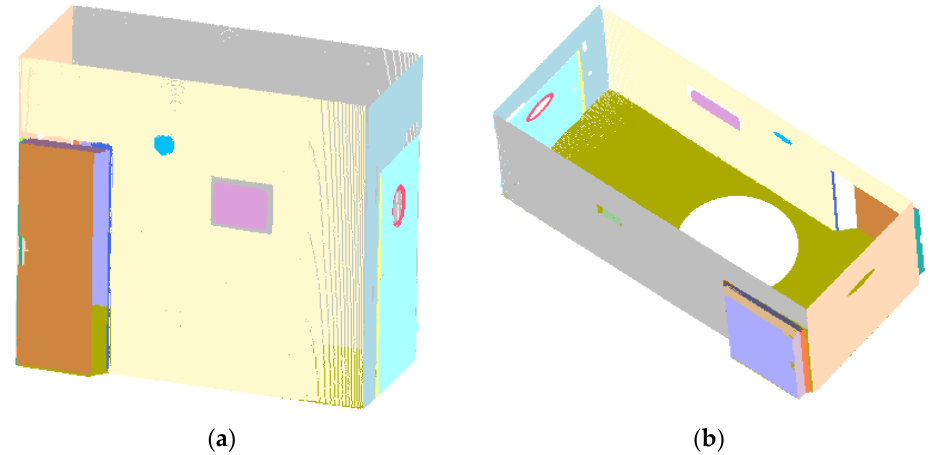
Figure 15. Cottage’s segmentation results using the proposed method under the optimal distance